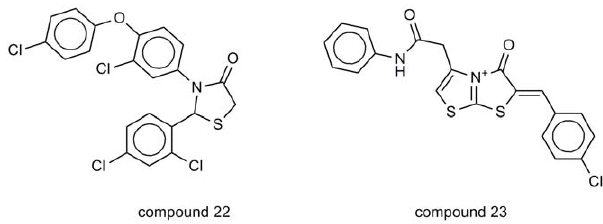
Figure 15. Two compounds showing feature trees similarity of 0.876 to the compound 12b were also retrieved in